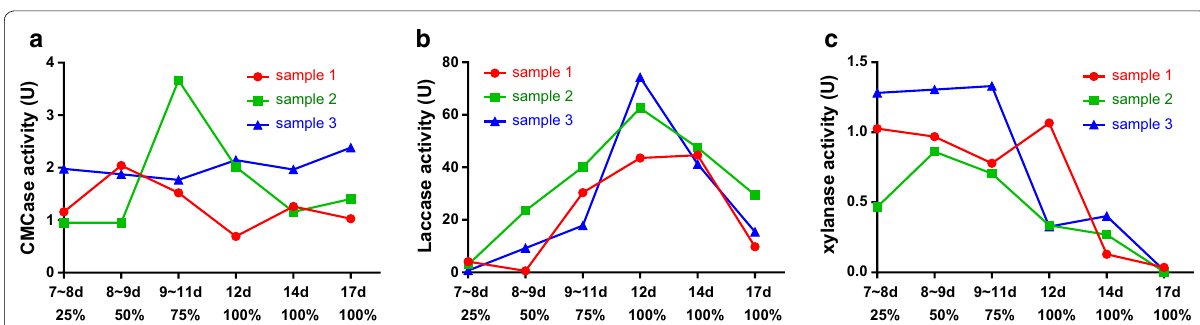
Fig. 2 a CMCase activity of C. comatus during solid-state fermentation. b Laccase activity of C. comatus during solid-state fermentation. c Xylanase activity of C. comatus during solid-state